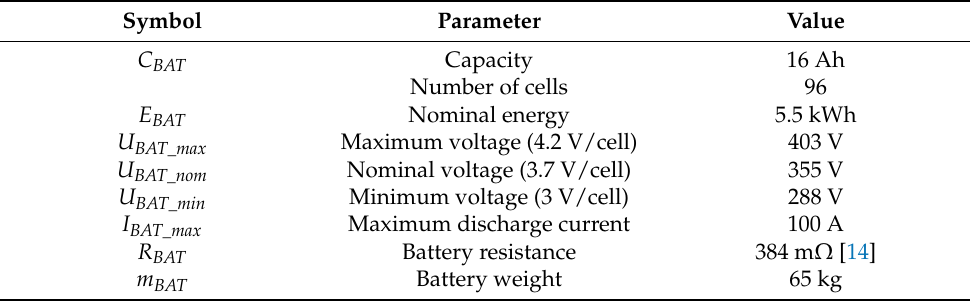
Table 2. Parameters of the battery pack for the AOS-H2 motor